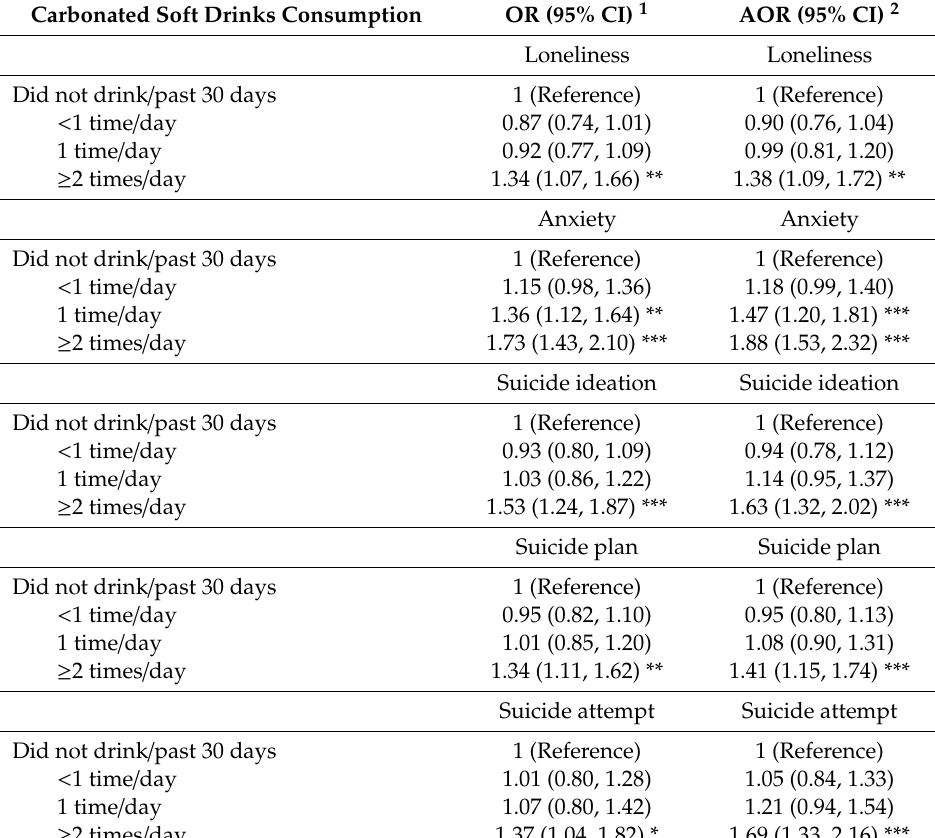
Table 5. Associations between soft drink use frequency and poor mental